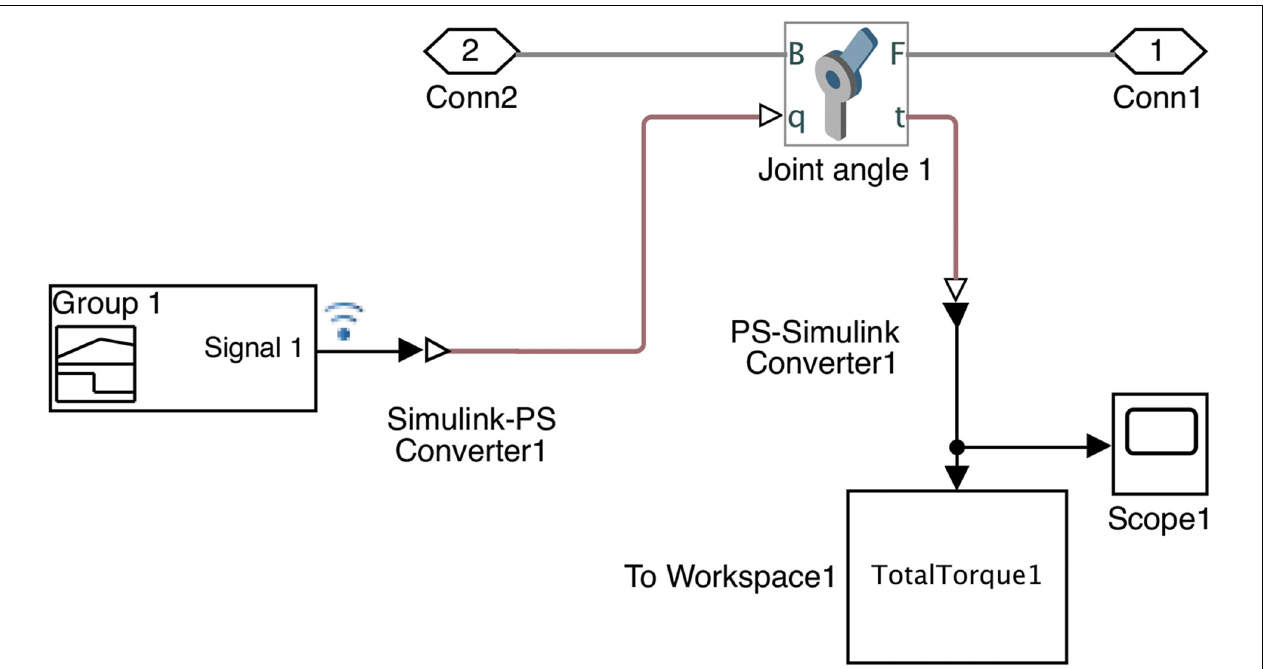
FIGURE 8 | Subsystem of the “Revolute Joint 1”.